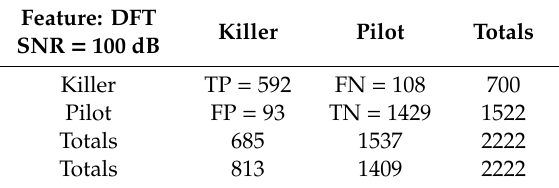
Table 4. Classification results: DFT, SNR = 100 dB.